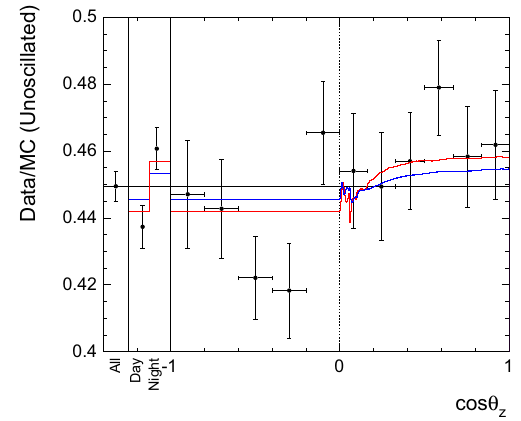
Fig. 14 The separated measurement of the solar day and night time flux in terms of the solar zenith angle distribution (only for SK-IV 1664 daysofdata)[64].Theredlineandbluelinearetheexpectedfluxforthe best fit value of the solar global analysis and for that of the KamLAND analysis